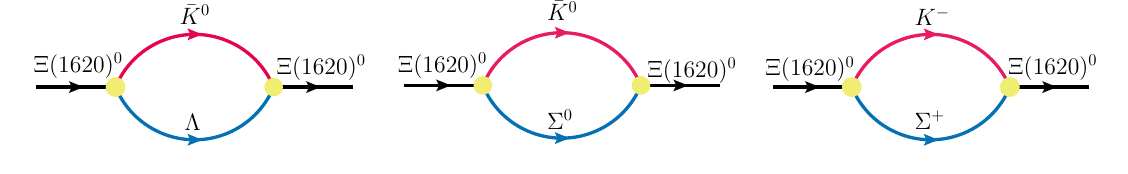
Fig. 1 Self-energy of the Ξ (1620) state